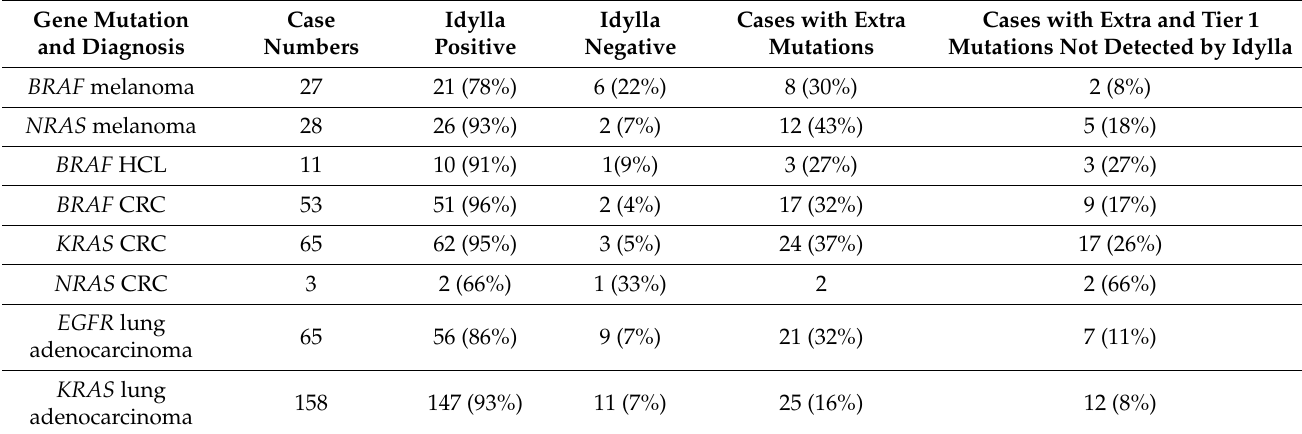
Table 2. Gene mutations and associated specific